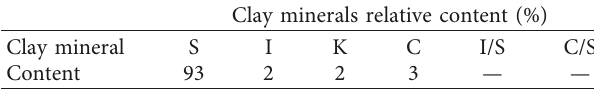
Table 1: Clay mineral X-ray diffraction analysis results. Table 3: Hydraulic properties of swelling soft rock Clay minerals relative content (%)